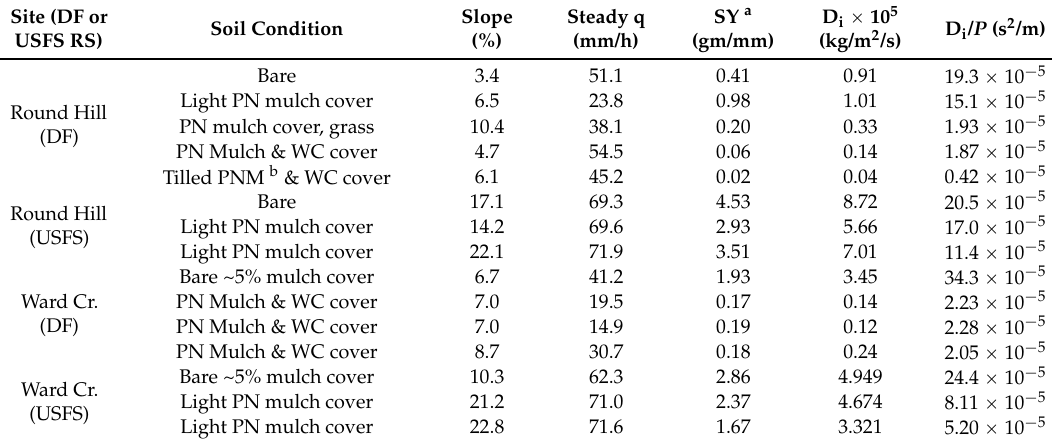
Table 14. Summary of plot data for stream power derived soil erodibility for granitic and volcanic soil forest landing RS plots for short DF RS and USFS sprinkler